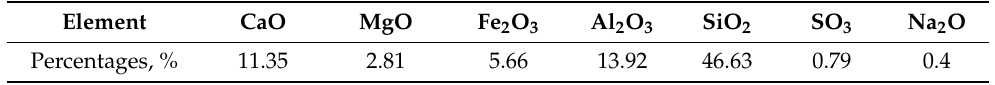
Table 2. Chemical composition of